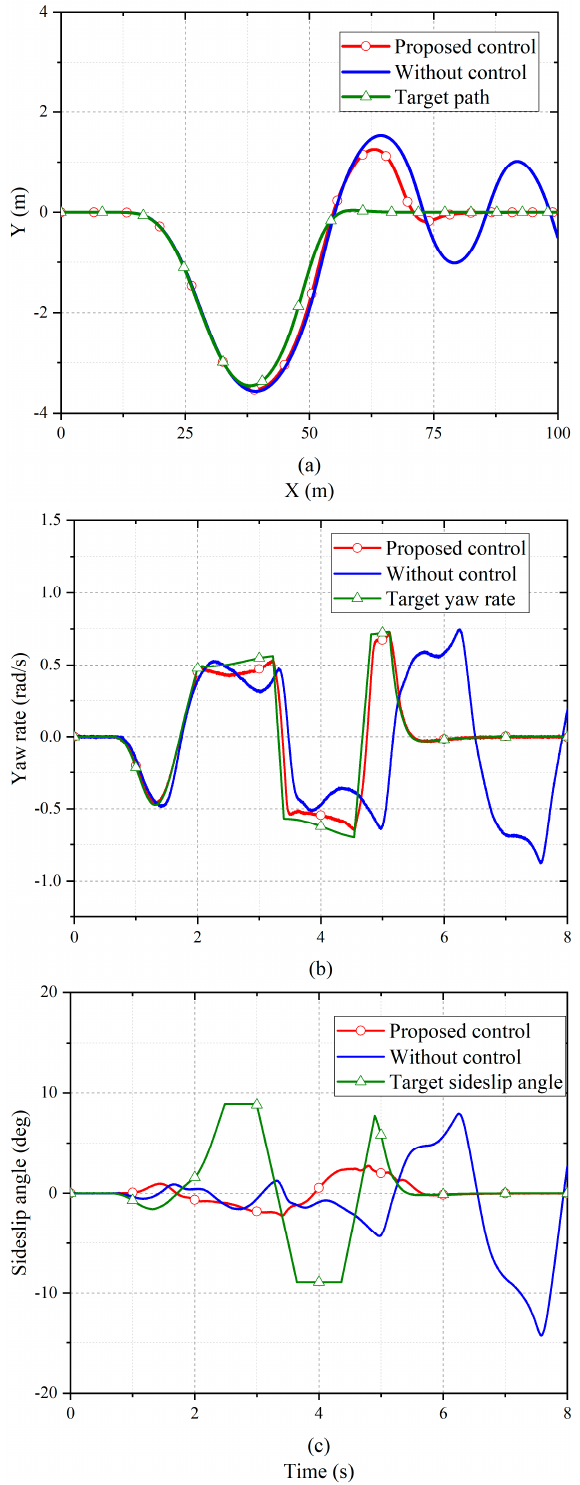
Figure 5. Comparison of the vehicles with and without the proposed optimal torque distribution control method: (a) path tracking; (b) yaw rate responses; (c) sideslip angle responses.